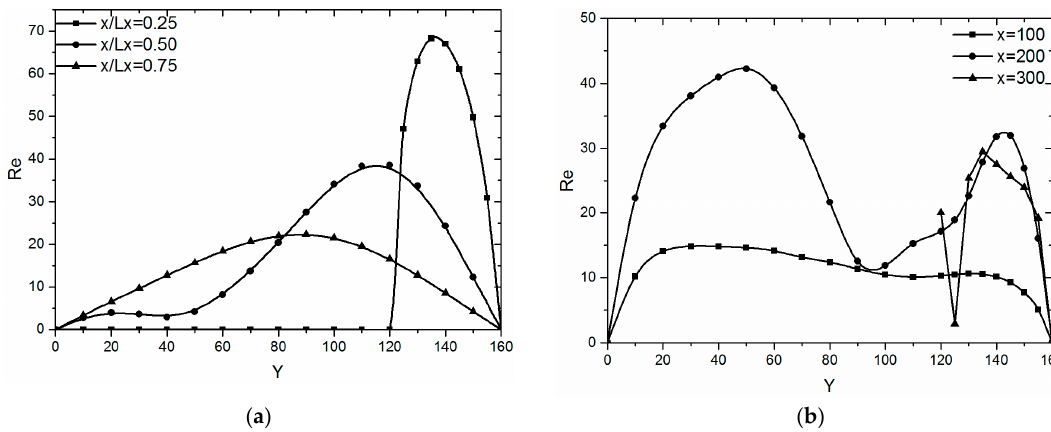
Figure 7. Re varies with Y -axis on different sections. ( a ) Static pin fin (x/Lx = 0.25); ( b ) Moving pin fin (x/Lx = 0.75).